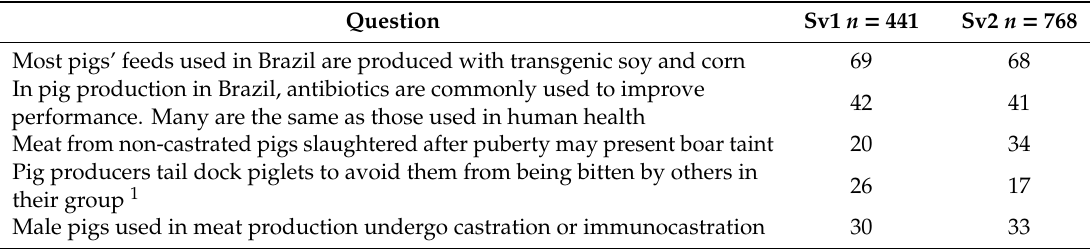
Table 2. Awareness (%) of some pig production